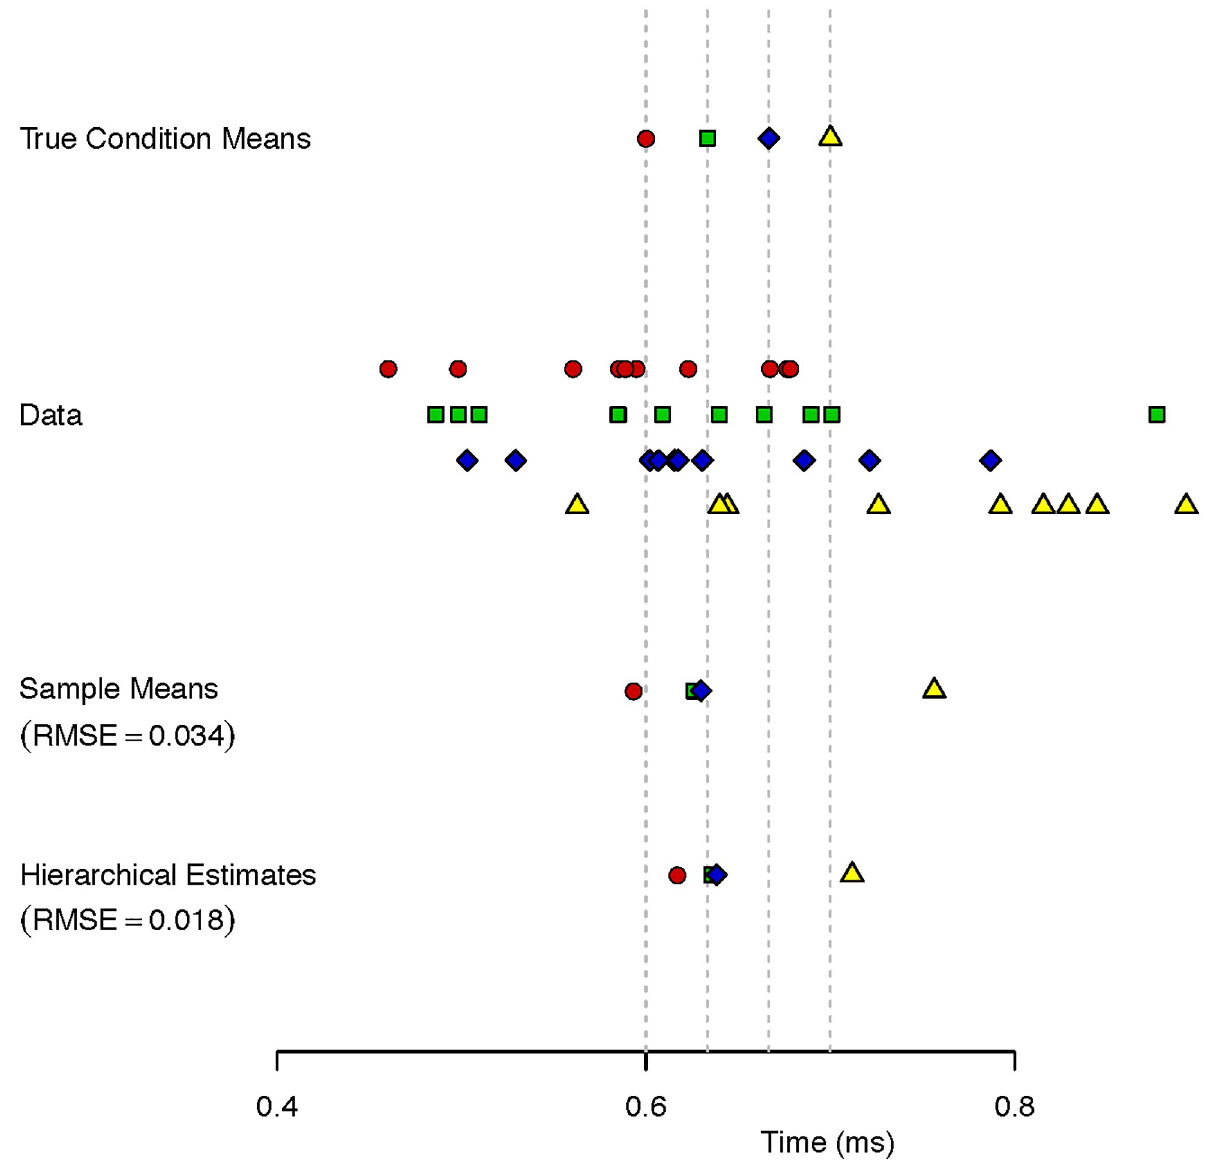
Fig 2. The benefits of shrinkage. True values, data, sample means, and a Bayesian hierarchical shrinkage estimates are shown. The shrinkage estimates are more accurate in this case as well as on average across repeated samples from the true values.